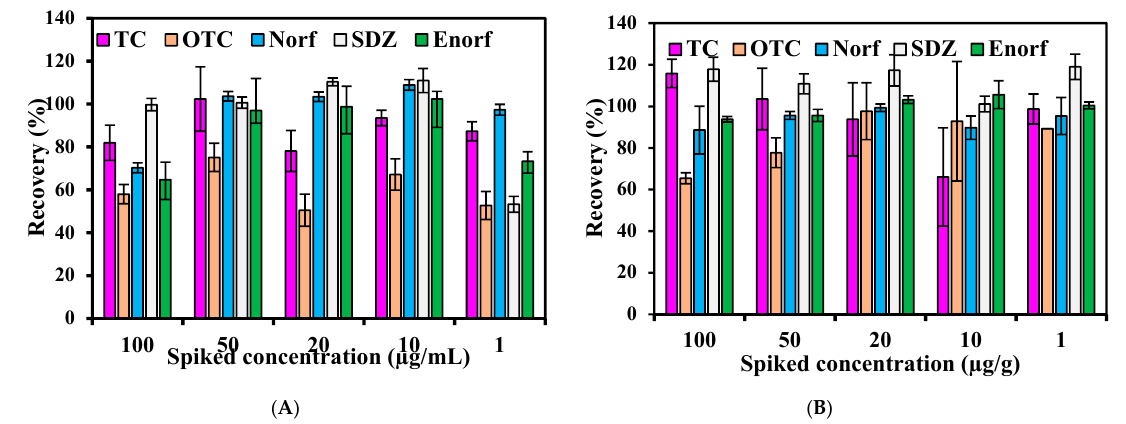
Figure 2. VAs recovery in liquid fraction ( A ) and solid fraction ( B ) at pH 3.0, mobile phase (2). Table 2. Instrument conditions of UHPLC combined with on-line SPE for analyzing five VAs.